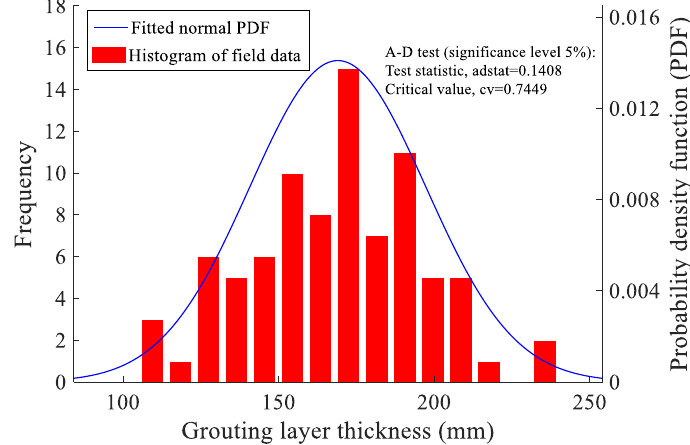
Table 1. Statistic parameters of grouting-layer thickness.